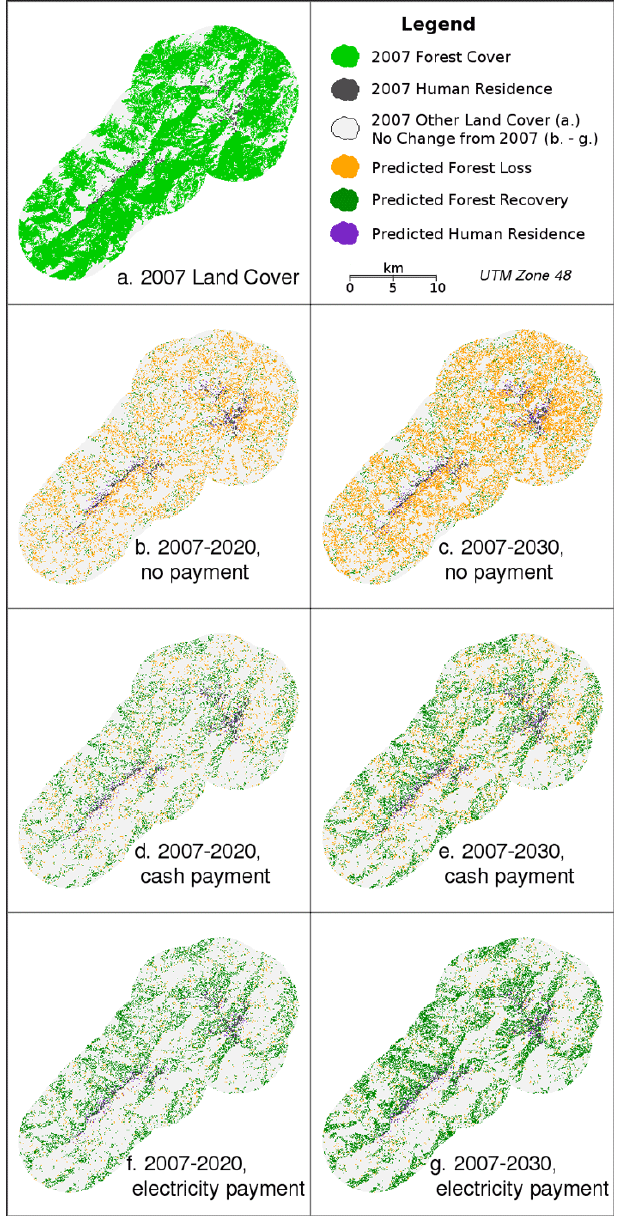
Fig. 3 . Distribution of forests and human residence observed in 2007 (a), and predicted changes in 2020 (b) and 2030 (c) under no-payment scenario, 2020 (d) and 2030 (e) under cash payment scenario, and 2020 (f) and 2030 (g) under electricity payment scenario. Note that these maps are made based on results from one run only, although the number of replicates is 30 for all simulation experiments.